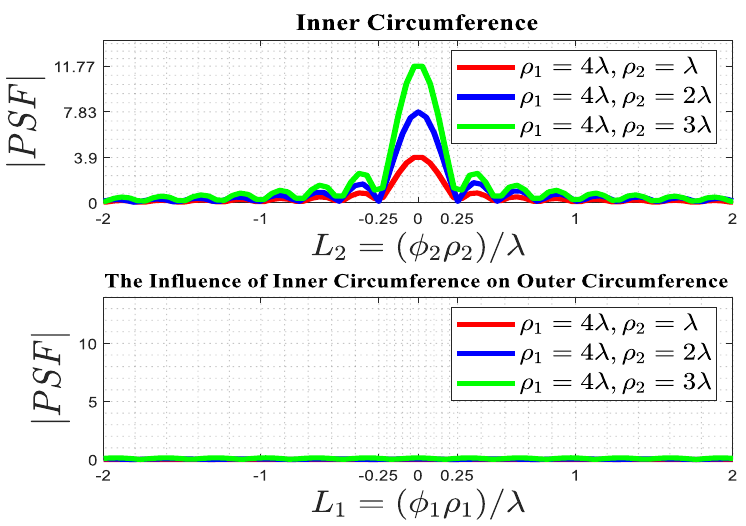
Figure 8. The PSF of the inner circumference and its effectiveness on the one.